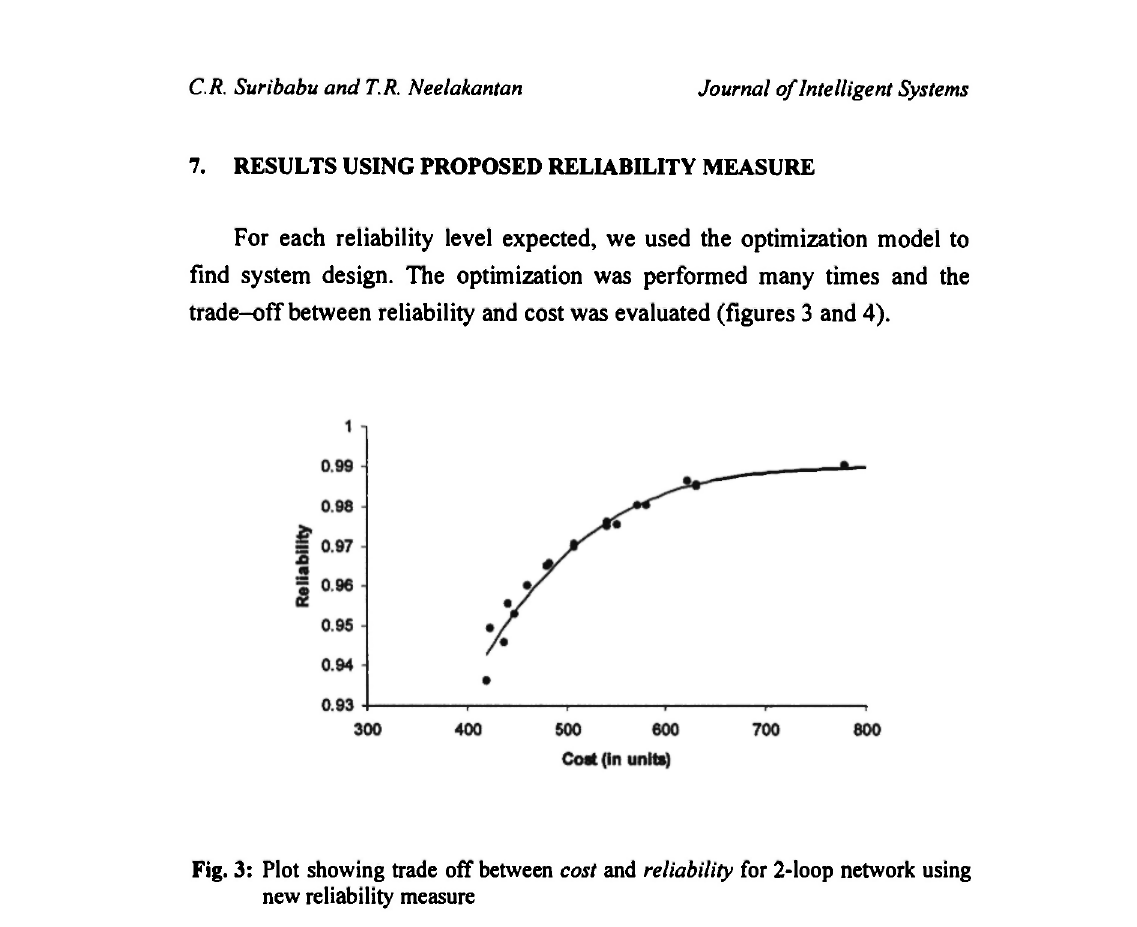
Fig. 3: Plot showing trade off between cost and reliability for 2-loop network using new reliability measure